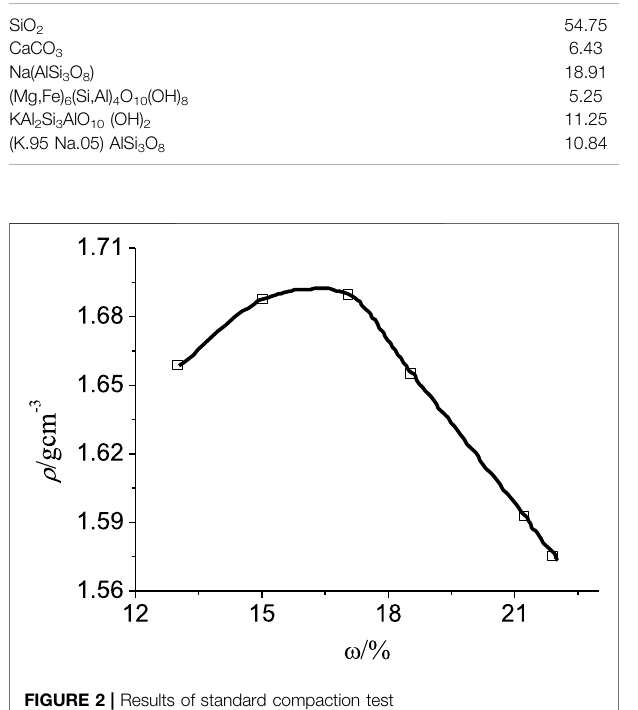
FIGURE 2 | Results of standard compaction test